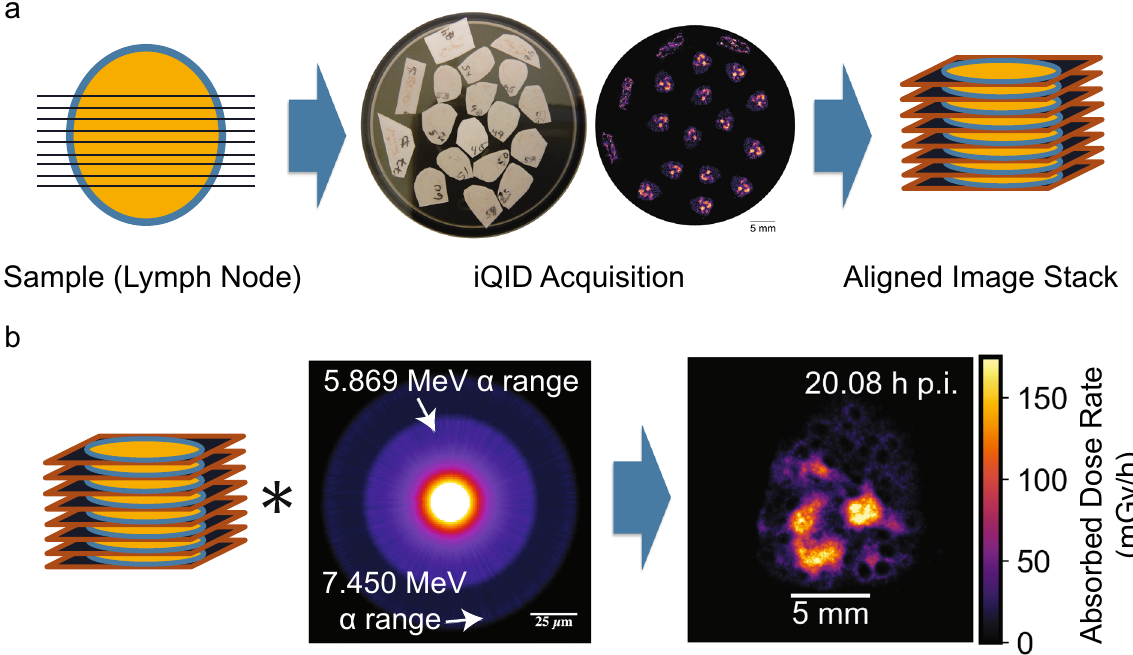
Figure 1. Overview of dosimetry with iQID digital autoradiography. ( a ) Cartoon schematic of data acquisition. Thin (12 µm) cryosections were cut from a tissue biopsy, imaged in 2D with an iQID device, and re-aligned into a 3D volume using image processing. ( b ) Convolution of the registered activity image stack with a 3D 211 At Monte Carlo dose kernel produced dose-rate maps of canine lymph node slices. iQID scale bars (5 mm) were based on field-of-view reference images and voxel